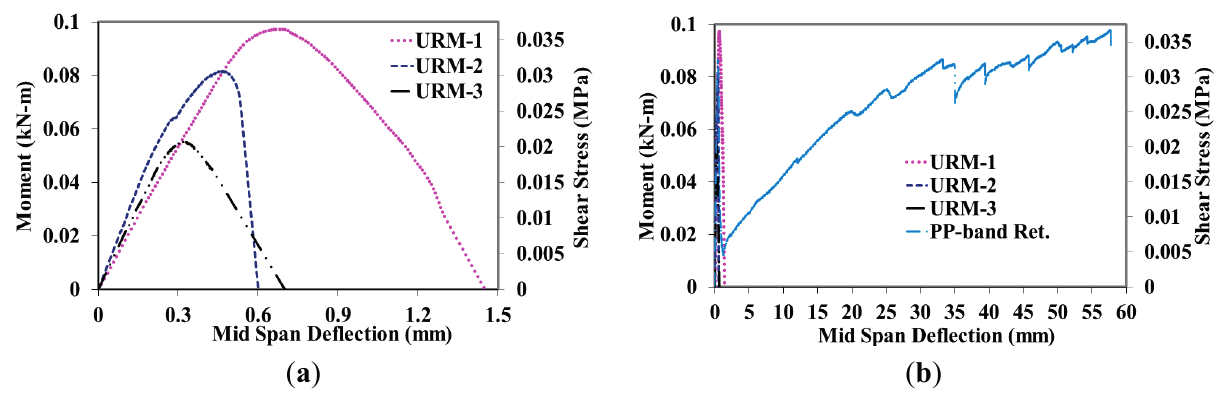
Figure 4. Moment-deflection curves of masonry panels under bending test for ( a ) URM and ( b ) PP-band retrofitted.